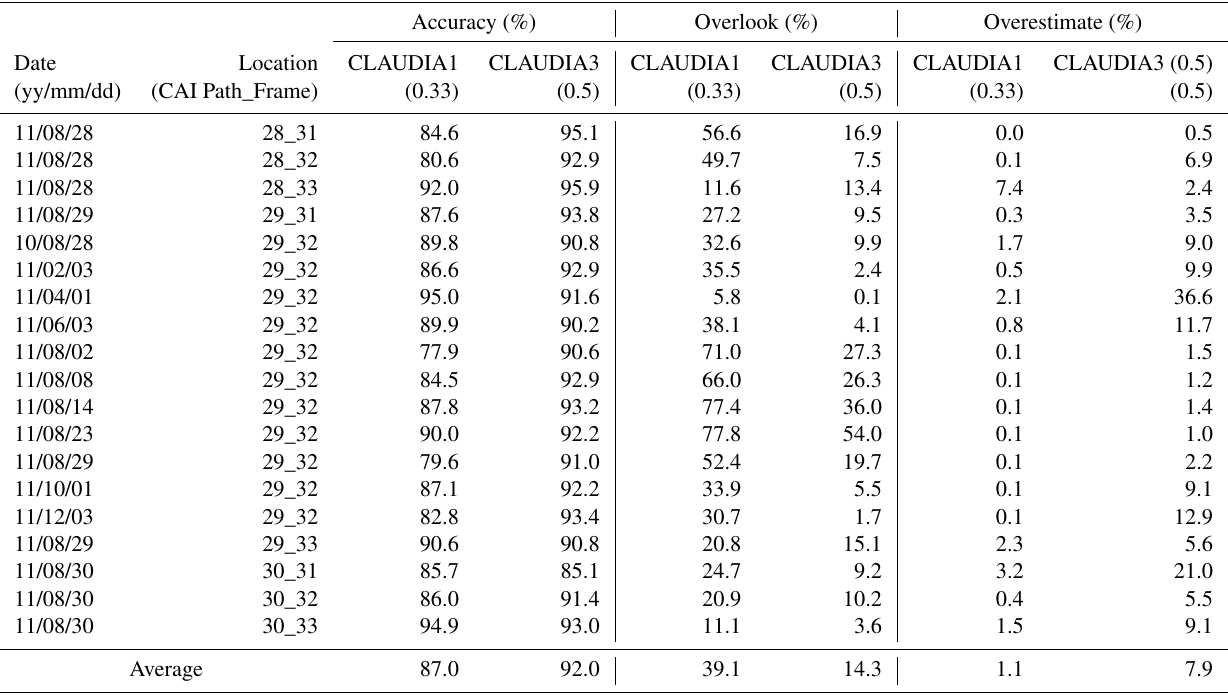
Table 5. Results for integrated-CCL thresholds of 0.33 for CLAUDIA1–CAI and 0.5 for CLAUDIA3–CAI in the Amazon. Accuracy (%) Overlook (%)